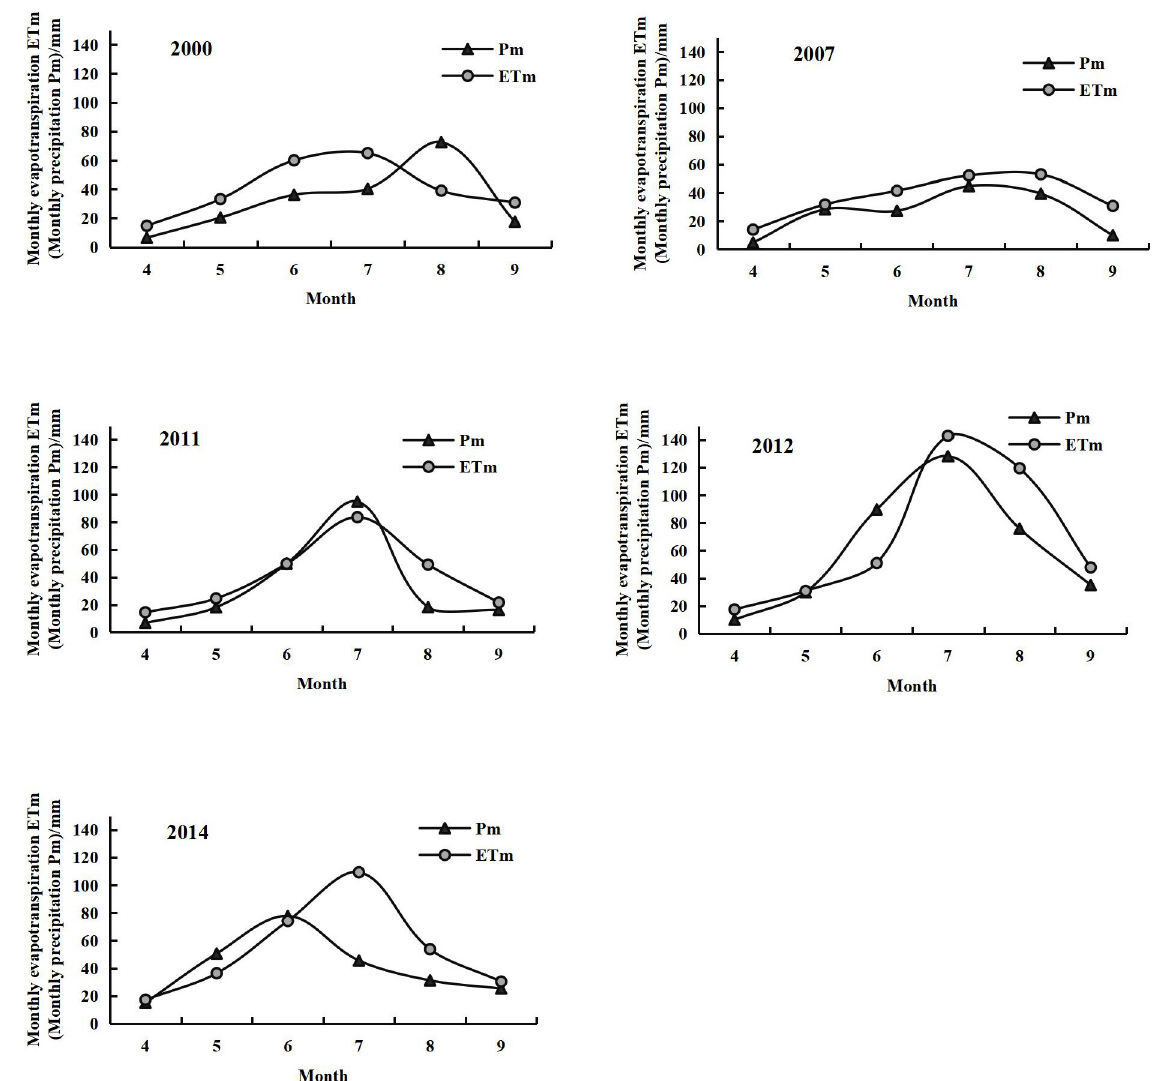
Fig 8. Changes in the evapotranspiration and precipitation during the growing seasons of different years.